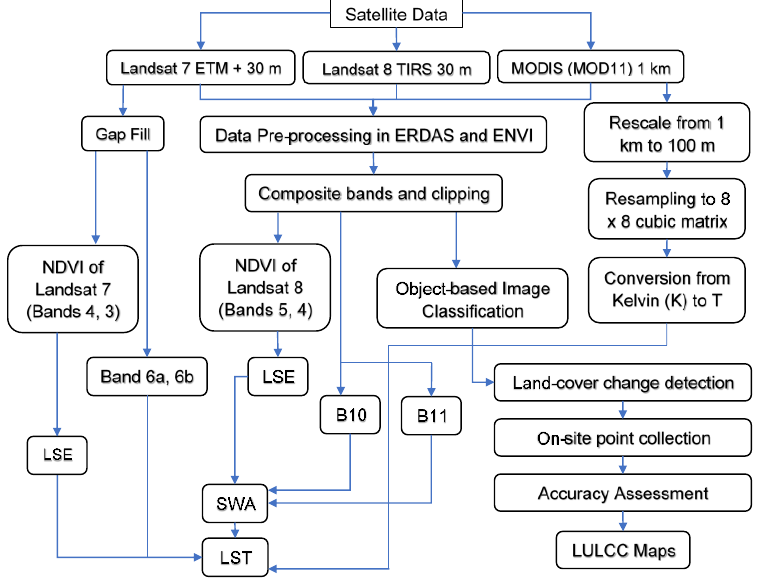
Figure 3. Image analysis retrieval flowchart.